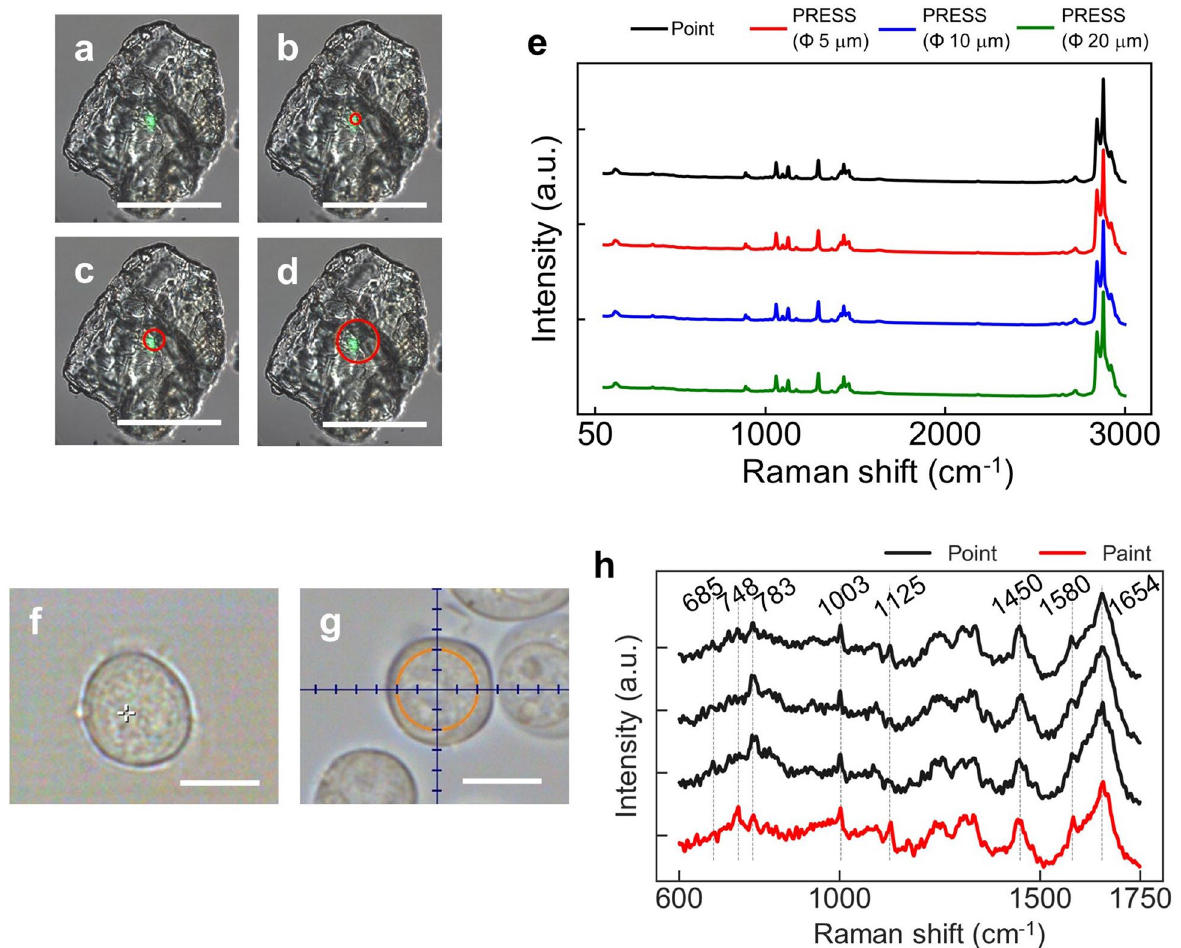
Figure 2. Comparison between Raman spectra by point and paint scanning. ( a – d ) Bright field image of solid palmitic acid. ( a ) Point-scan (laser spot diameter: < 450 nm) or ( b-d ) PRESS (circular areas of 5, 10, and 20 μm diameter: Φ 5, 10, and 20 μm). Scale bar: 50 μm. ( e ) Raman spectra detected by point-scan (black line), PRESS (Φ 5 μm: red line, Φ 10 μm: blue line, Φ 20 μm: green line). ( f – g ) Bright field image of Jurkat cells obtained by point-scan ( f ) or PRESS ( g , Φ 10 μm). Scale bar: 10 μm. ( h ) Raman spectra detected by three point-scan (black line) or by PRESS (red line) from the same Jurkat cell. Some well-known biological peaks are shown: cytochrome C (748 and 1580 cm −1 ), nucleic acids (783 cm −1 ), proteins (1003, 1450 and 1654 cm −1 ), and lipids (1125 cm −1